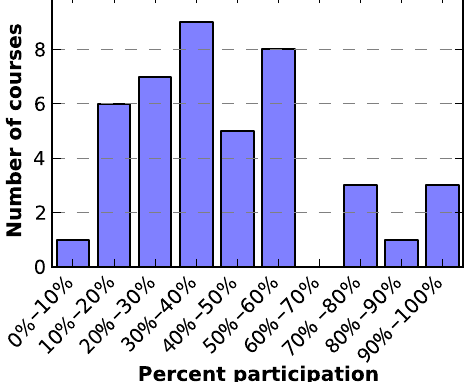
FIG. 9. Distribution of participation levels for all classes taking the E-CLASS survey. The percentage is calculated by diving the number of matched pre and post responses by the total number of students reported to be enrolled in